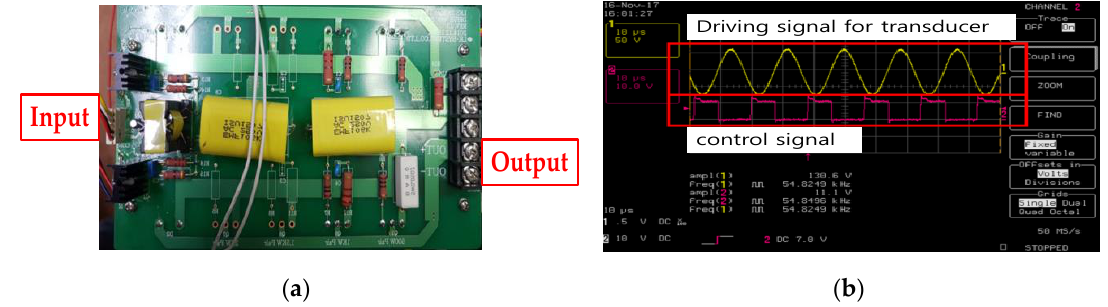
Figure 15. ( a ) Fabricated driving circuit and ( b ) driving and control signal for the BLUT.